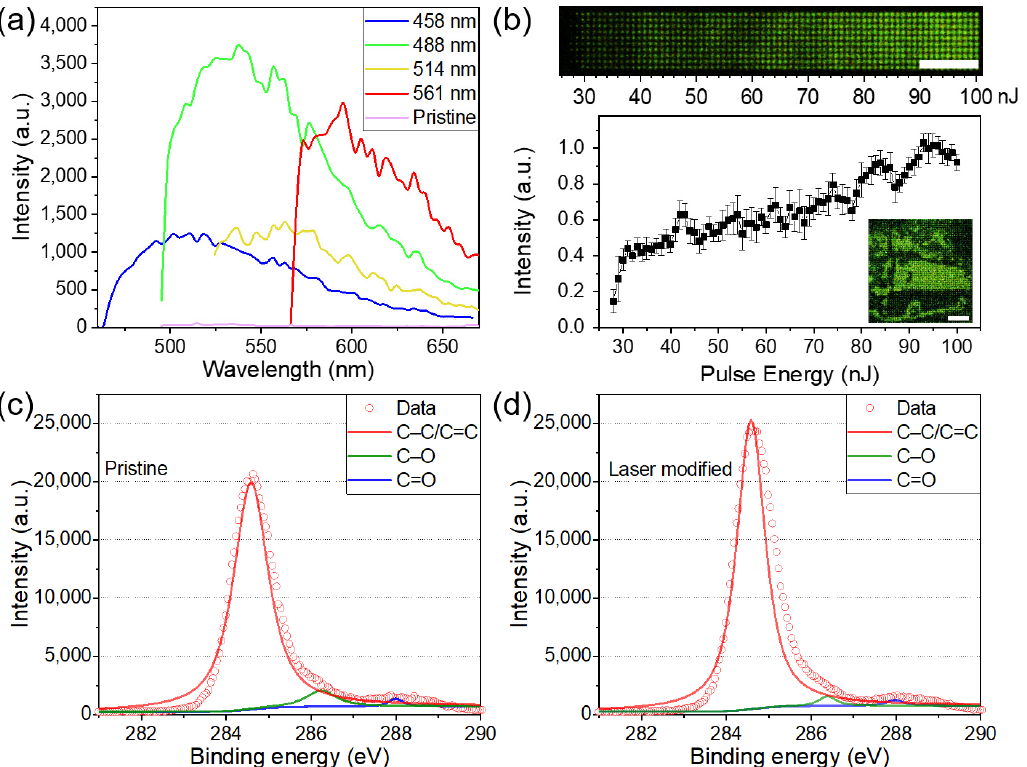
Figure 2. ( a ) Photoluminescence spectra of modified PVA samples for different excitation wavelengths and pristine PVA sample for the excitation wavelength of 488 nm. ( b ) Confocal fluorescence microscopy image of voxel array excited at 488 nm. Fluorescence intensity as a function of pulse energy. The inset is a 4-level picture of a bus. The scale bars are 50 µm. XPS spectra of ( c ) the pristine PVA sample and ( d ) the laser-modified PVA sample.